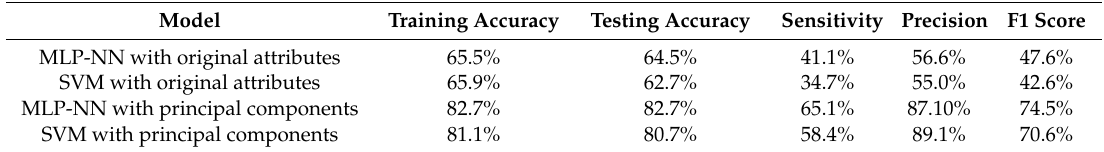
Table 3. Performance measures of the developed models (serious / fatal injury crashes).